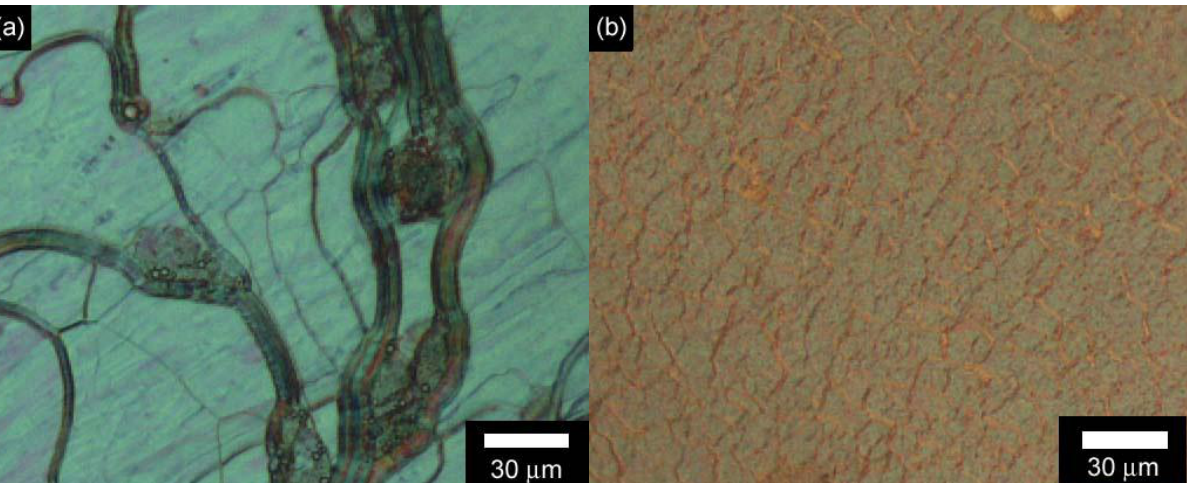
Figure 6. Polarizing optical microscopic (POM) images of the reaction mixture of P1LC before polymerization (a) and P1LC after polymerization (b)